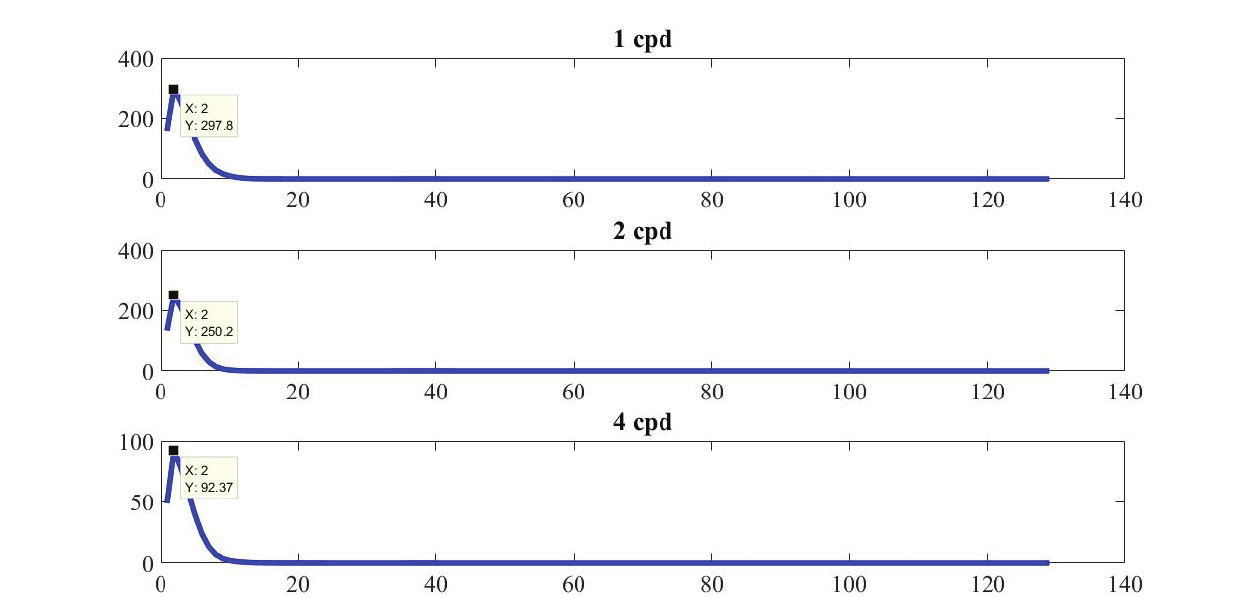
Figure 2. F extracted from the Power Spectral Density (PSD) of pattern-reversal visual evoked potentials at 1, 2, and 4 cpd. mod F is the peak frequency in the PSD (approximately 2 mod